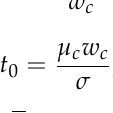
Figure 5. Variation of the dimensionless droplet length with different disperse phase fractions in three different junction configurations.